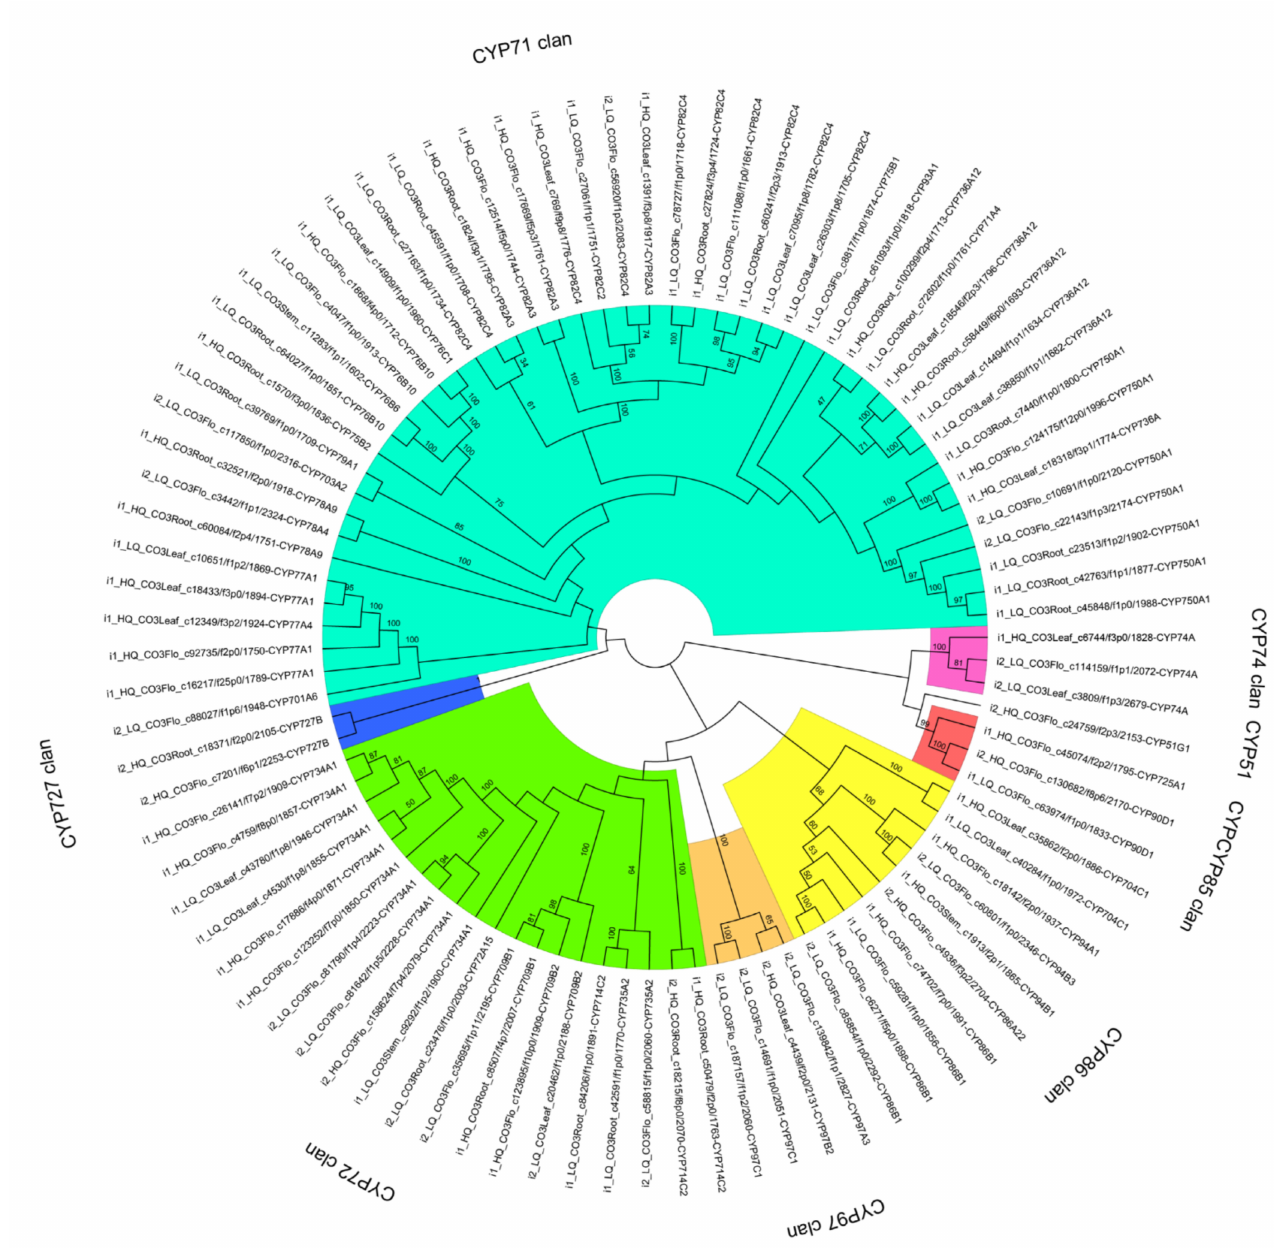
Figure 8. Phylogenetic analyses performed with 256 cytochrome P450 (CYP450) sequences of C. oliveri . Most proteins encoded by unigenes were expressed in the four tissue (Figure 9). More- over, JAZ (jasmonate ZIM domain-containing protein, K13464), IAA (auxin-responsive protein IAA, K14484), SAUR (SAUR family protein, K14488), PYL (abscisic acid receptor PYR/PYL family, K14496), PP2C (protein phosphatase 2C, K14497) and SNRK2 (serine/ threonine-protein kinase, K14498) had high expression levels in four tissues. In addition, the expression of TCH4 (xyloglucan: xyloglucosyl transferase, K14504) in male cone was significantly higher than that of the other three tissues. The expression of ARF (auxin response factor, K14486), BIN2 (protein brassinosteroid insensitive 2, K14502) and BZR1_2 (brassinosteroid resistant 1/2, K14503) in the root were significantly higher than that of the other three